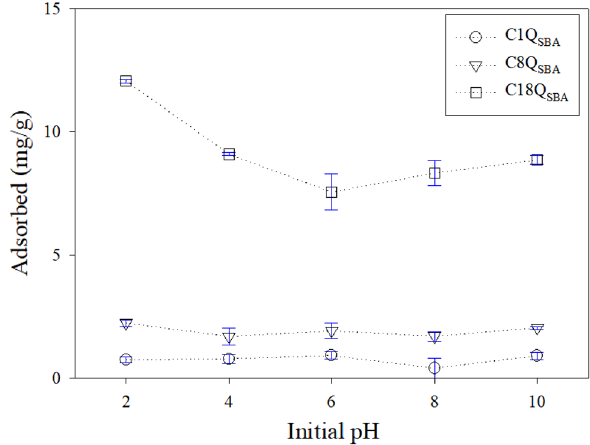
Figure 4. Effect of pH on CBZ adsorption by Q SBA